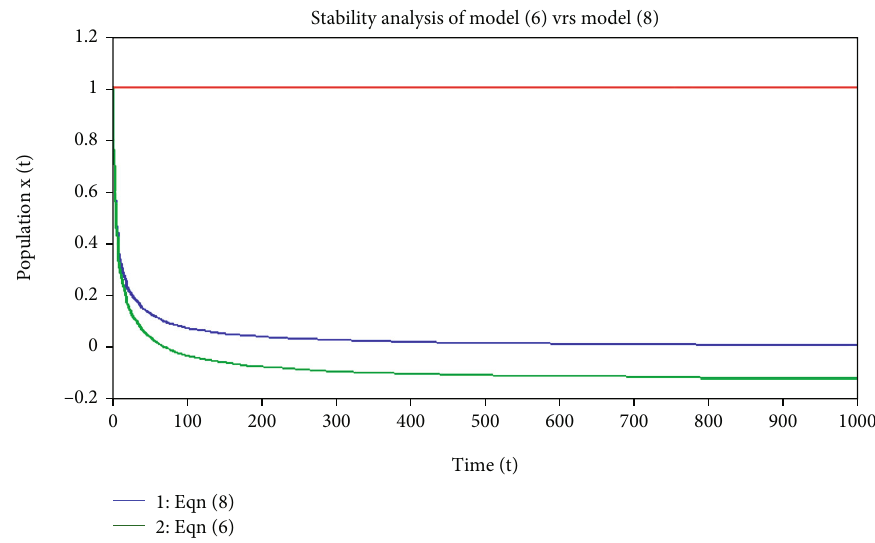
Figure 3: Stability analysis of equations (6) and (8) with r = 0 : 1 , τ = 3 : 00 , and h = 0 : 1 .